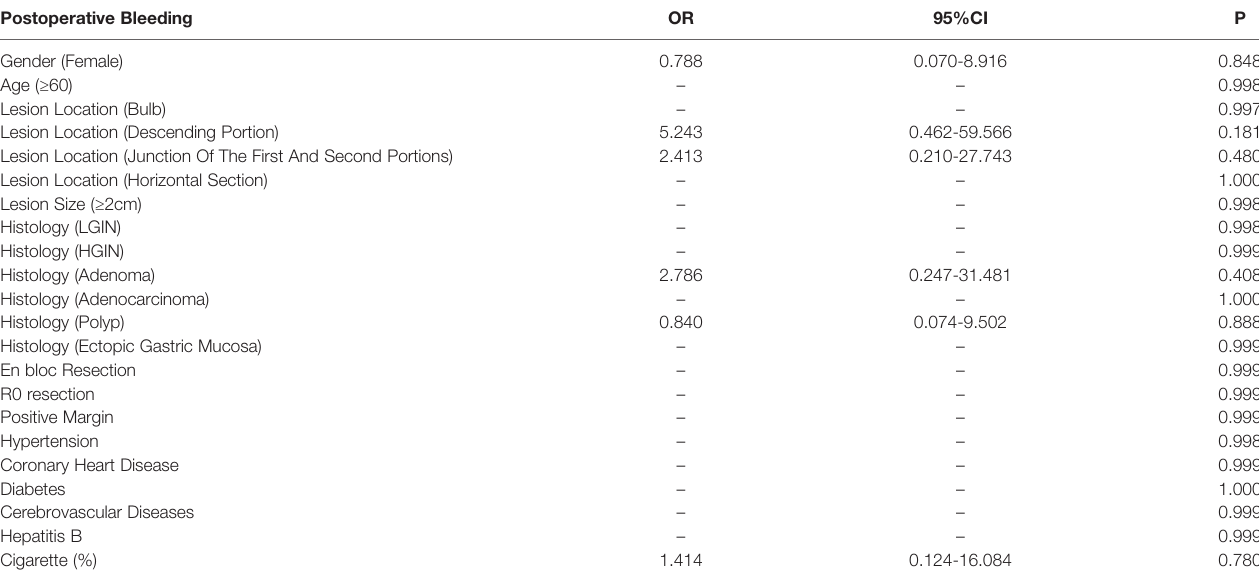
TABLE 2 | Univariate logistic regression of postoperative complications. Postoperative Bleeding